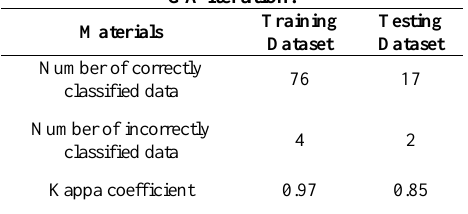
Table 4. Results of proposed model with 200 times GA